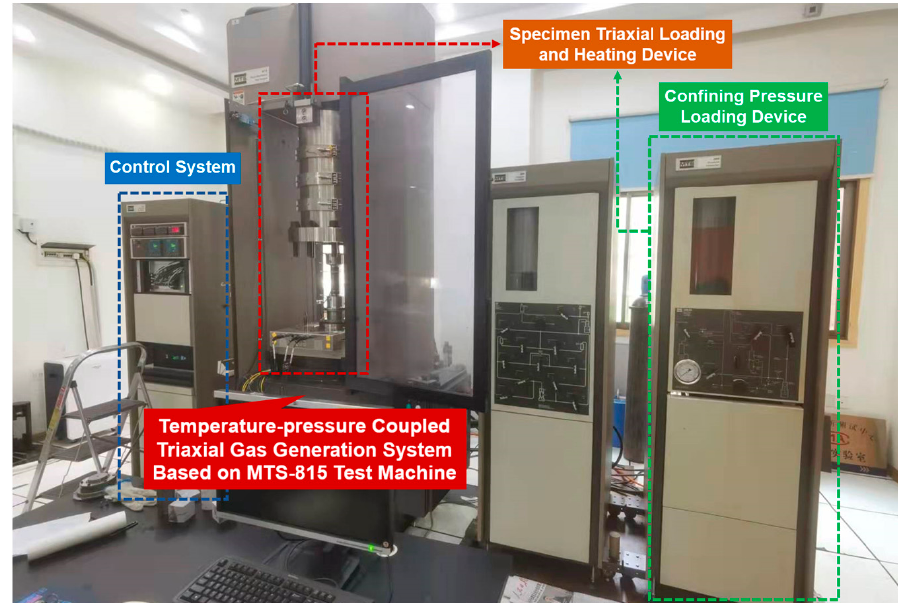
Figure 2. MTS-815 triaxial loading test system.